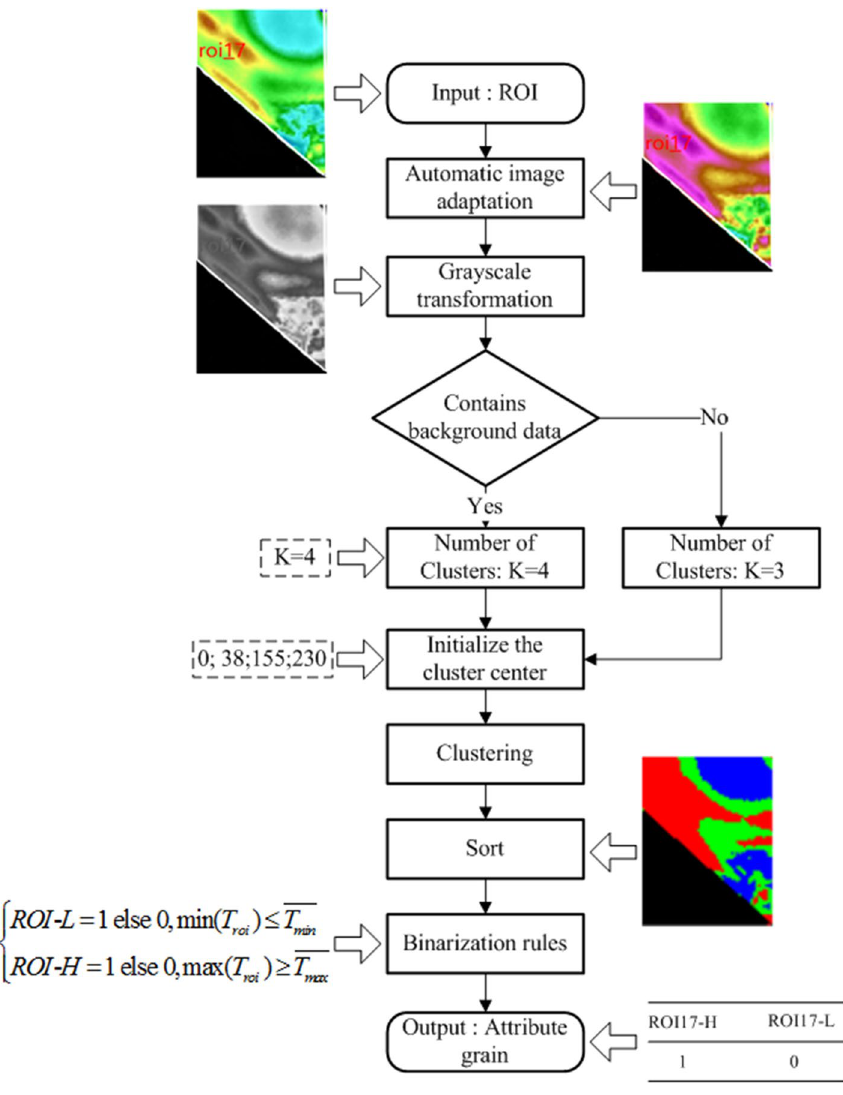
Figure 4. Flow chart of data